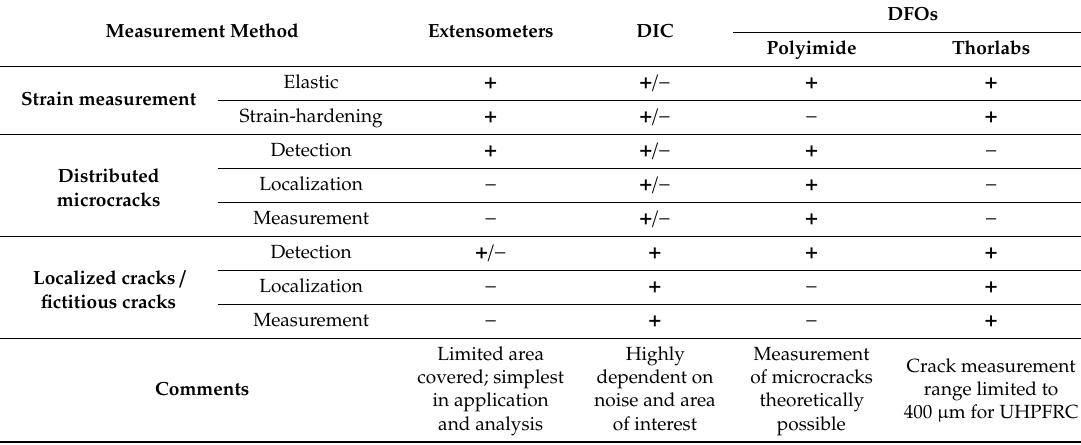
Table 1. Comparison of used measurement methods regarding their application